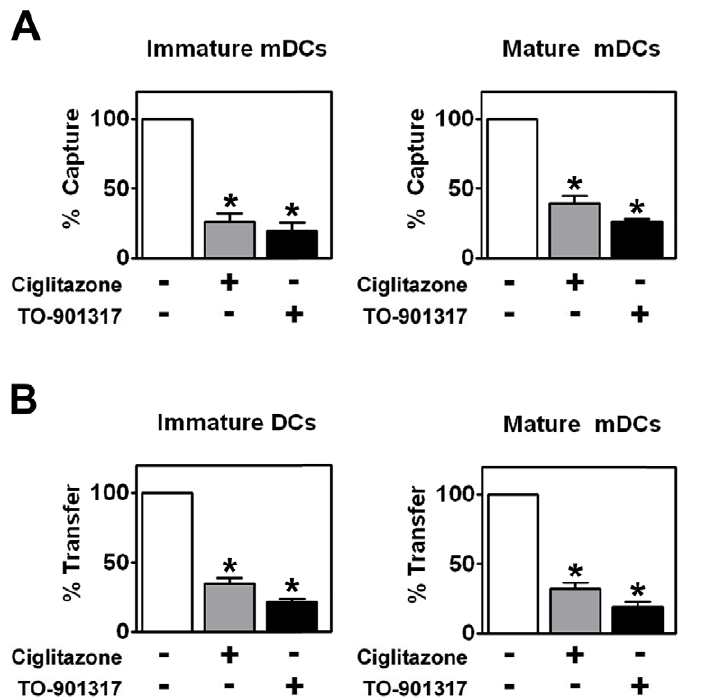
Figure 6. PPAR c and LXR ligand treatment inhibit myeloid DC-mediated HIV-1 capture and trans -infection. (A) Immature (left panel) and mature (right panel) mDCs were treated with 100 m M ciglitazone or 1 m M TO-901317 for 48 hours. The mDCs were then incubated with HIV-1 ADA and virus capture was measured by p24 gag ELISA. (n=4) (B) Immature (left panel) and LPS-matured (right panel) mDCs were treated for 48 hours with 100 m M ciglitazone or 1 m M TO-901317, incubated with HIV-1 ADA , washed, and cultured directly with autologous T cells. Virus transfer was measured by p24 gag ELISA. (n=4) * p , 0.001 compared to untreated controls.